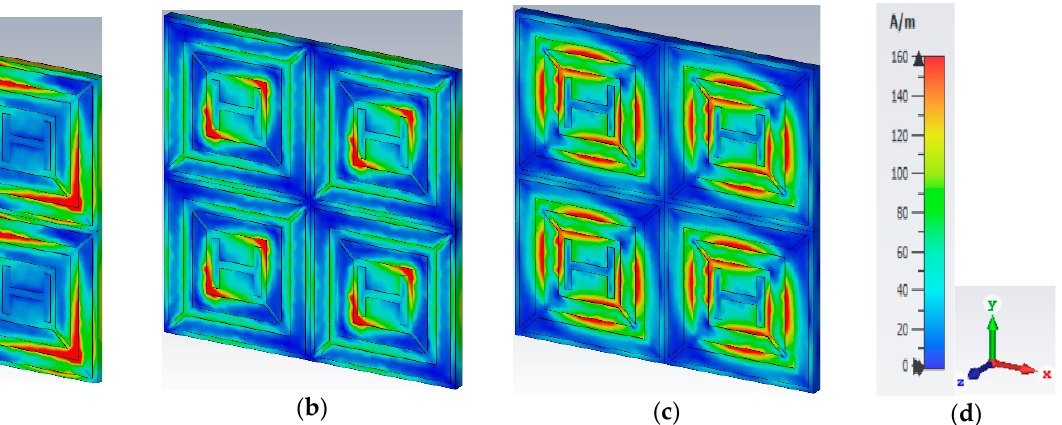
Figure 8. Magnetic field at ( a ) 6.24 GHz; ( b ) 10.608 GHz; ( c ) 18.624 GHz. ( d ) Scale and axis.